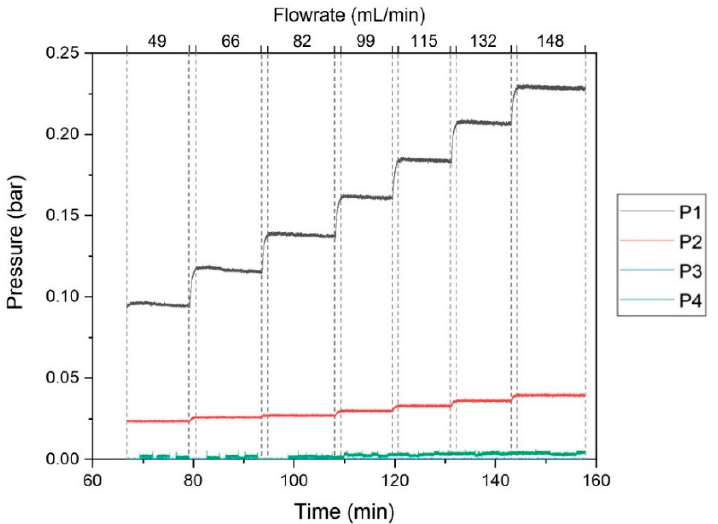
Figure 3. Pressure profile of the circuit during the circulation of DI water through the SHDMM circuit at different values of Q F , which are indicated delimited by the dashed lines. The pressure data is color-coded according to the different sensors: black line—P1, red line—P2, green line—P3, and dark blue line—P4.